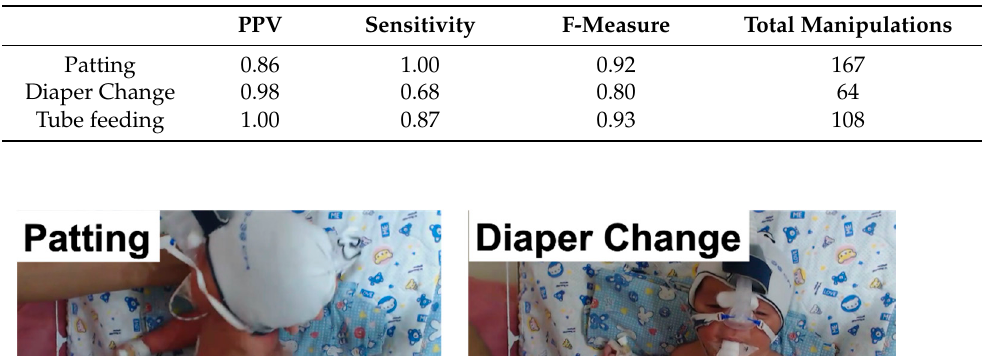
Table 5. Performance of deep learning model.